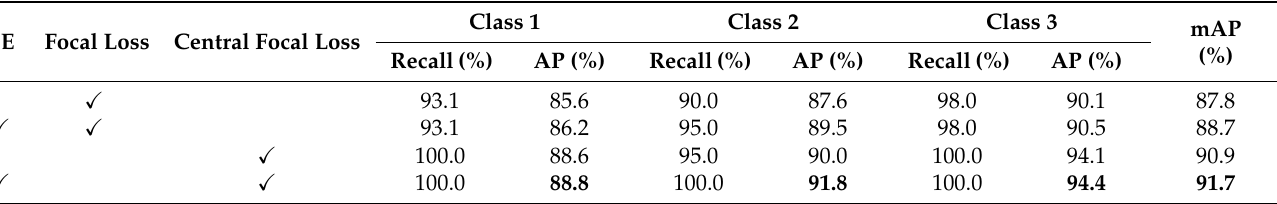
Table 1. Ablation experiment with RetinaNet.